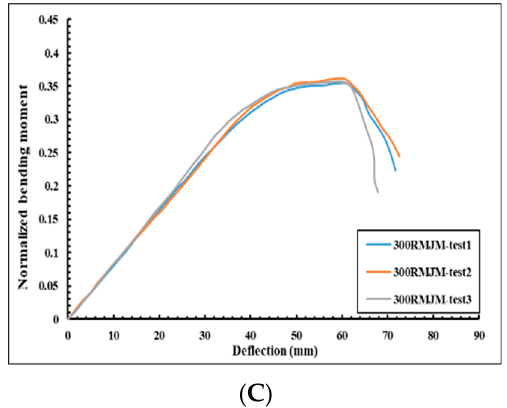
Figure 10. Normalized bending moment–deflection about major axis curves: ( A ) SMJM; ( B ) 200RMJM; ( C ) 300RMJM. Table 3. The ultimate normalized bending capacity of specimens in the major axis test. Test Specimen